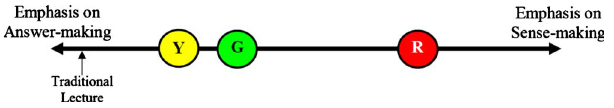
FIG. 7. (cid:1) Color (cid:2) A Continuum of a set of norms along the dimen- sion of answer-making versus sense-making.